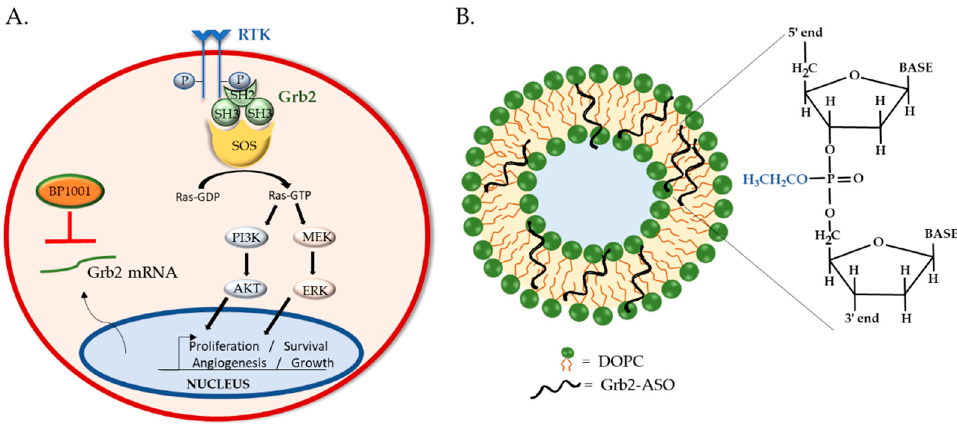
Figure 3. Grb2 signaling and BP1001 interference. ( A ) Grb2 is an adaptor protein that binds to phosphorylated receptor tyrosine kinases and mediates the activation of Ras via the recruitment of guanine exchange factor SOS. Ras activation initiates MAPK/ERK and PI3K/AKT signaling. ( B ) BP1001 is a liposomal-incorporated Grb2-ASO with a P-ethoxy modified backbone. It precludes Grb2 protein expression by blocking mRNA translation.